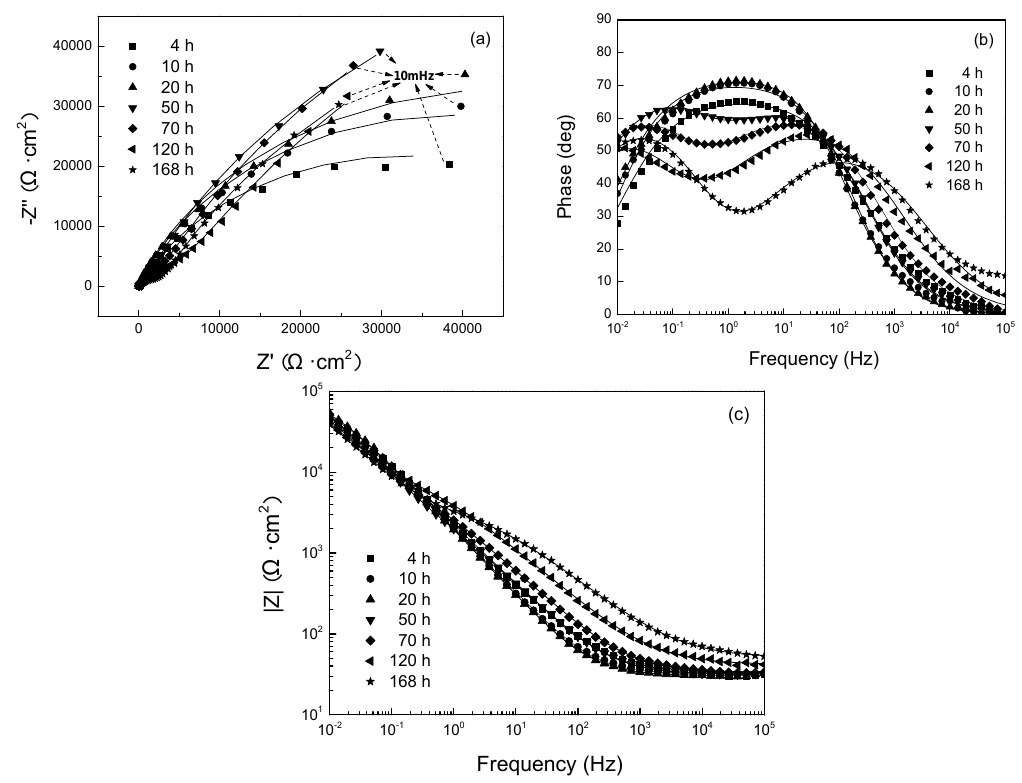
Figure 5. EIS evolution of 304 SS under polarization at − 0.65 V in sea water. Nyquist plot ( a ), Bode plot ( b , c ), in which symbols are measured data, lines are simulated data.